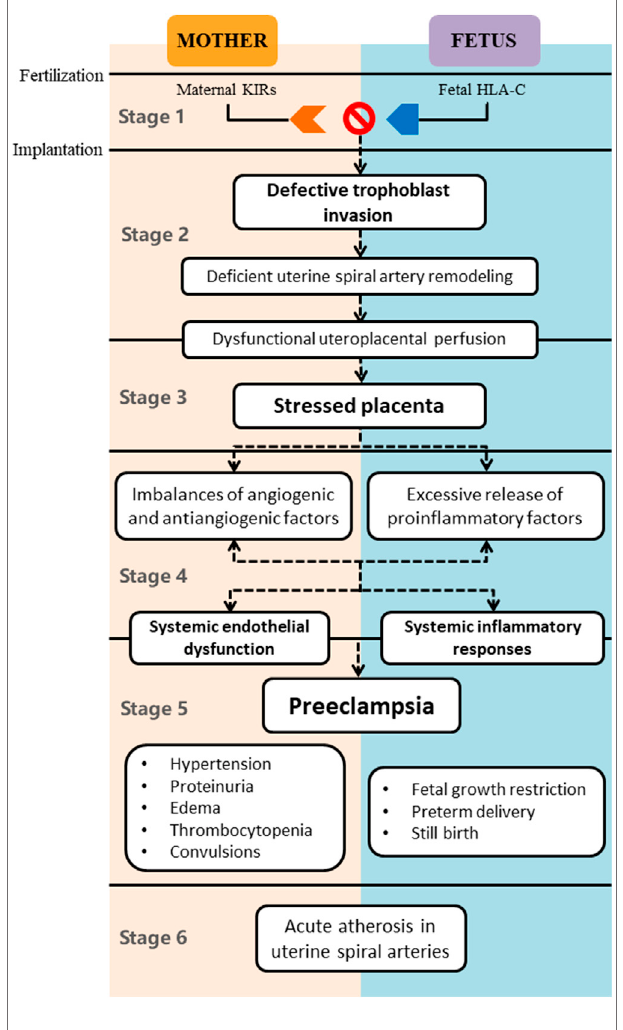
FIGURE 1 | Six-stage theory of PE